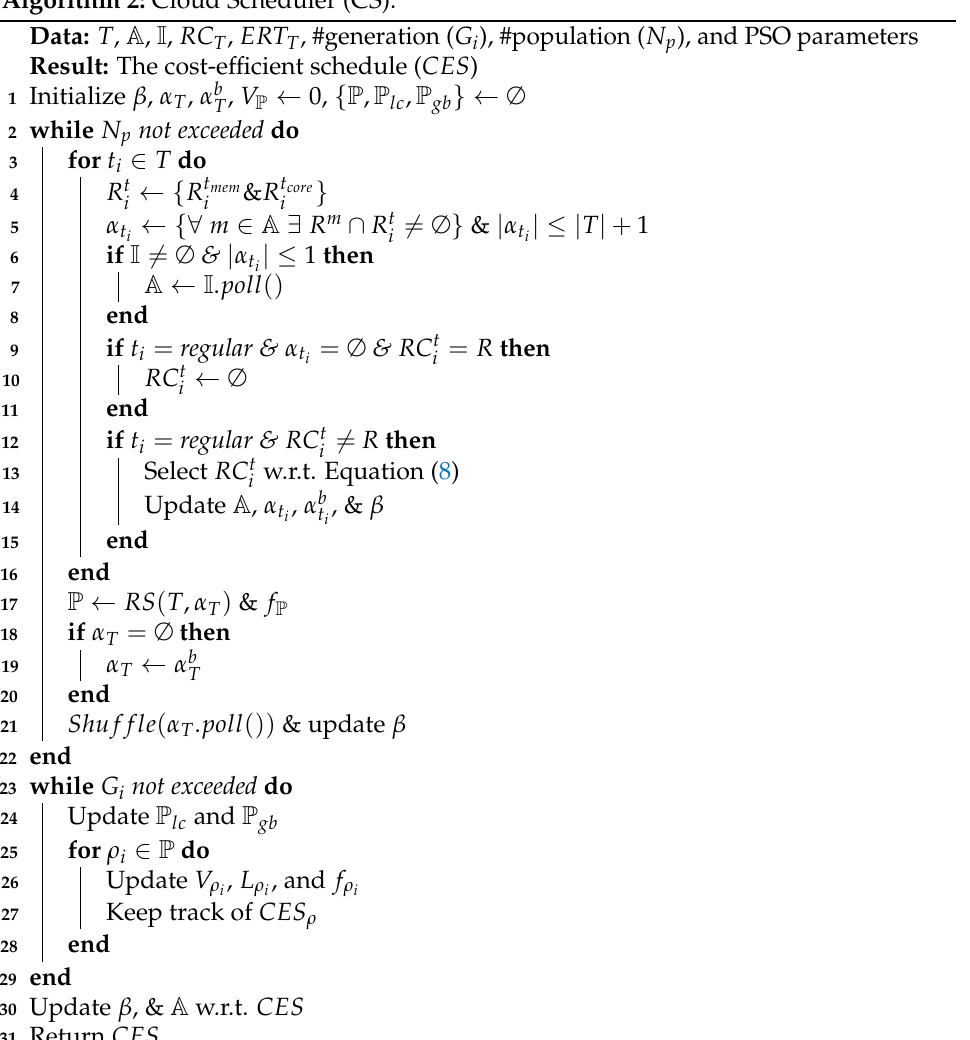
Algorithm 2: Cloud Scheduler